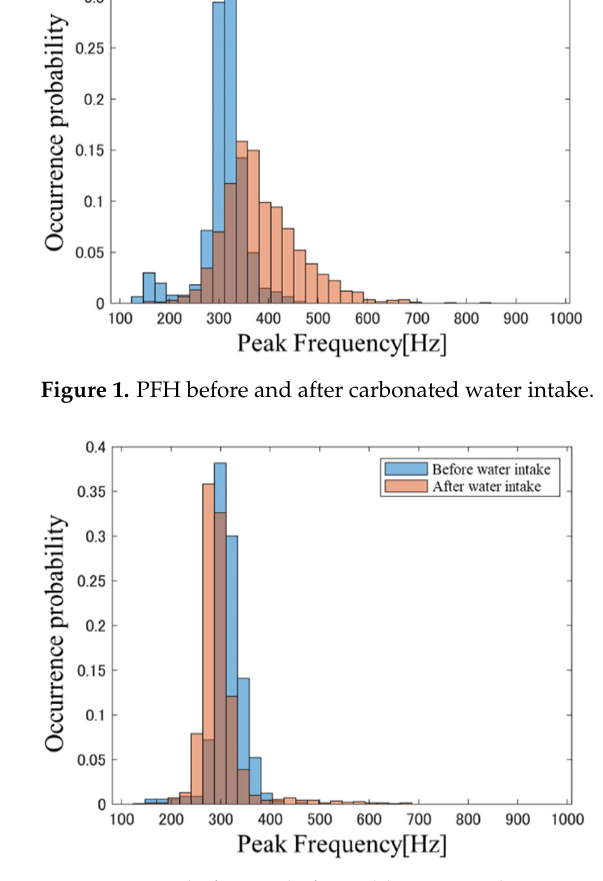
Figure 2. PFH before and after cold water intake.